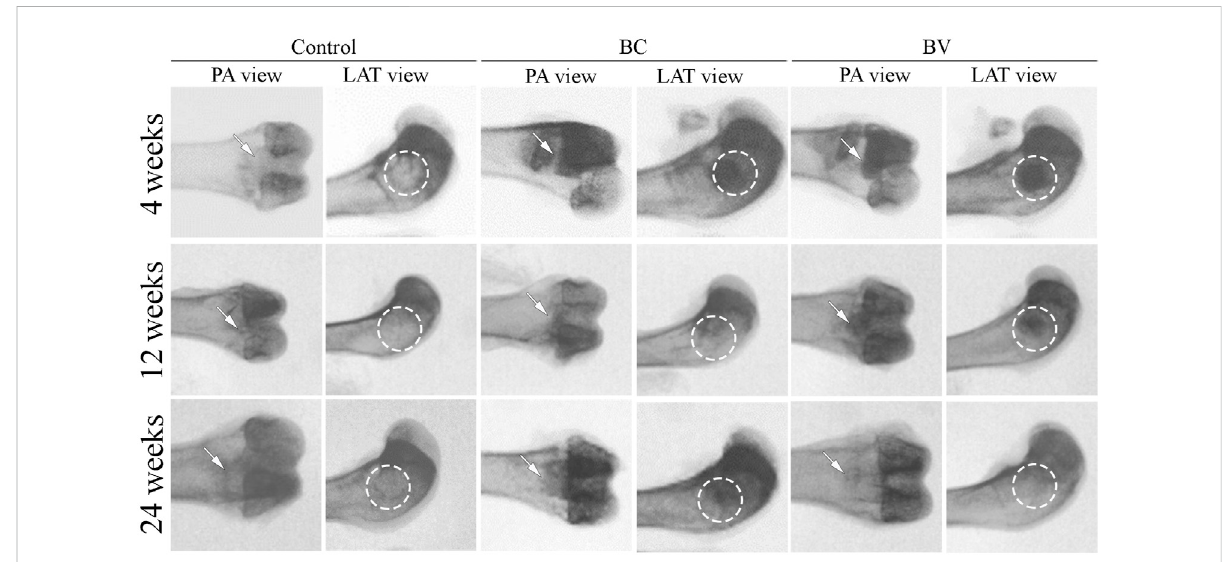
FIGURE 2 Radiographic images of rabbit femur condyle. The defect without implantation control remained an empty cavity. BC and BV were clearly observed at 4 weeks post-implantation, but the boundary between the implant and the surrounding bone started to become indistinct after 12 weeks. At 24 weeks post-implantation, the boundary was indistinguishable. The white arrow and white dashed circle represented the implant sites. PA, Post-anterior view. LAT, Lateral view. (BC, Bicera ™ ; BV, Vancomycin-loaded Bicera ™